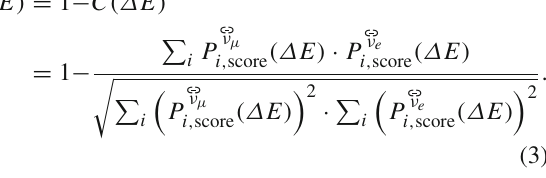
Fig. 7 Comparison of the classifier performance as a function of true neutrino energy in terms of the separation power metric as defined in Eq. 3. Separation power for training with (solid) and without (dashed) hit-based features is